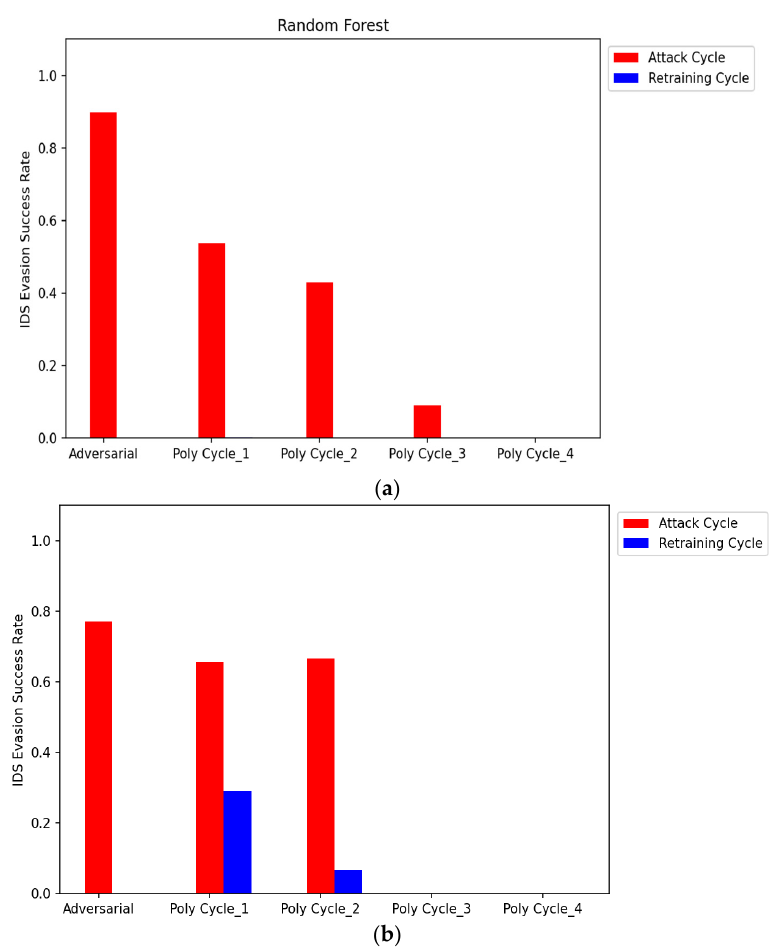
Figure 8. ( a ) Comparing the IDS evasion success rate for polymorphic adversarial attacks. The figure represents the results using Algorithm 3. ( b ) Comparing the IDS evasion success rate for polymorphic adversarial attacks. The figure represents the results using Algorithm 4. Table 4. Performance evaluation and comparison for random forest IDS on different adversarial polymorphic attacks using Algorithms 3 and 4 (Approach